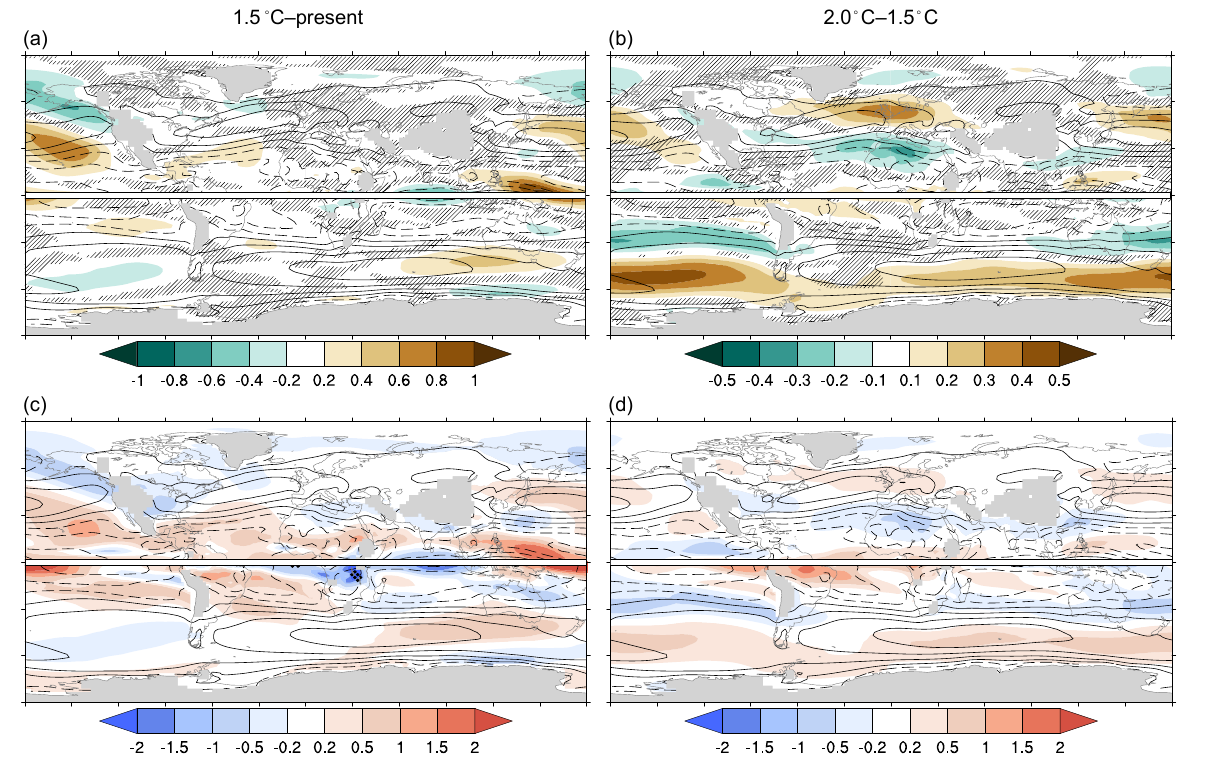
Figure 4. Multi-model mean response of winter (Northern Hemisphere DJF, Southern Hemisphere JJA) zonal wind at 850hPa ( u 850) for 1.5 ◦ C–PD (a, c) and 2.0–1.5 ◦ C (b, d) . Panels (a) and (b) show responses (shading; units ms − 1 ) along with the climatology (contour interval 4ms − 1 ) for the (a) PD and (b) 1.5 ◦ C experiments. Note the different colour scale for (a) and (b) . Panels (c) and (d) show signal-to-noise ratio β/σ , where the sign corresponds to the sign of the response, along with the climatology (contour interval 4ms − 1 ) for the (c) 1.5 ◦ C and (d) 2.0 ◦ C experiments. In (a) and (b) , hatching masks out regions where there is no model consensus (fewer than four out of five models agree) on the sign of the response. In (c) and (d) , black dots mask out regions where the models do not agree on the magnitude of the response ( f 2 > 1). Grey shading indicates regions of high topography intersecting the plotted